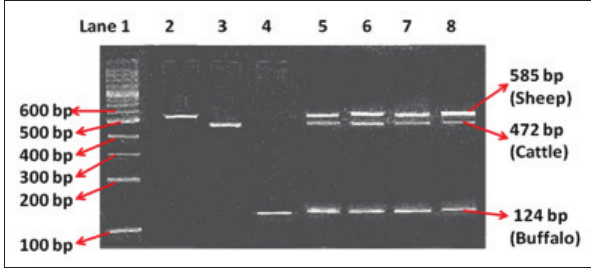
Figure-1: Species-specific multiplex polymerase chain reaction profile of cyt b gene fragments of sheep, cattle and buffalo from cooked Rista . Lane 1: DNA ladder, Lane 2: Pure mutton, Lane 3: Pure beef, Lane 4: Pure buffalo meat, Lane 5-8: Mixed meat (mutton:beef:buffalo meat in the ratio of 60:20:20, 80:10:10, 90:05:05 and 98:01:01,